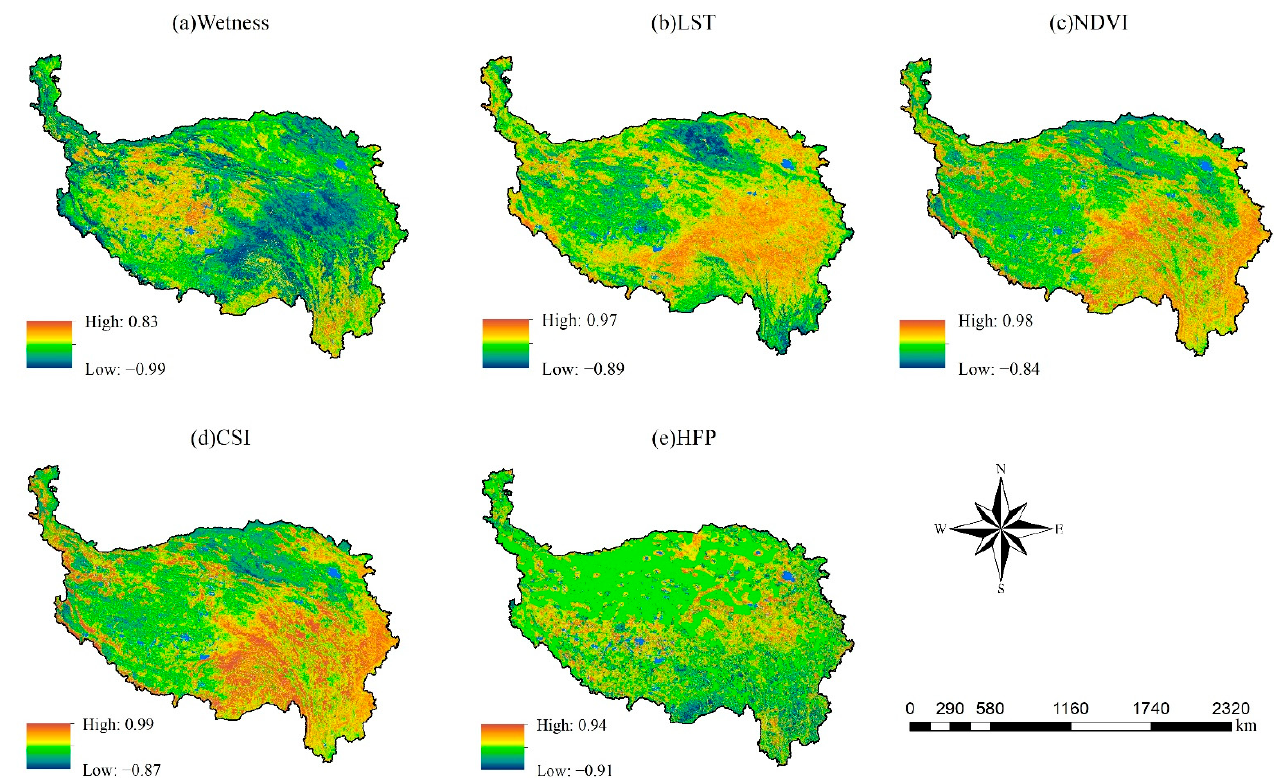
Figure 6. The spatial distribution of the Spearman correlation coefficient of the remote sensing ecological vulnerability index (RSEVI) correlated with wetness ( a ), land surface temperature ( b ), the normalized difference vegetation index ( c ), the comprehensive salinity index ( d ), and the human footprint ( e ) on the Qinghai-Tibet Plateau.